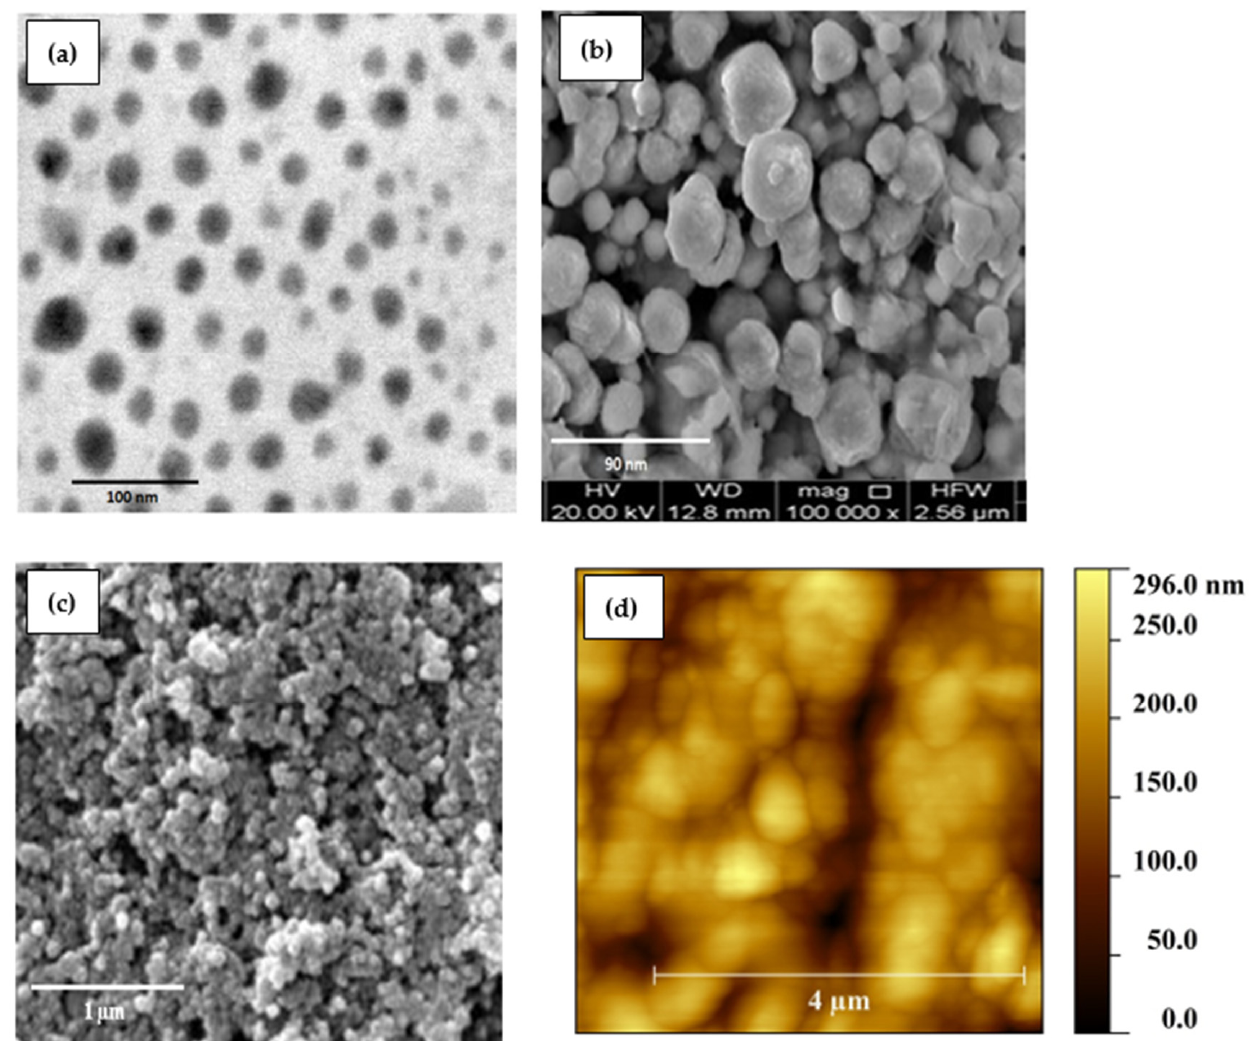
Figure 2. ( a ) TEM and ( b ) SEM images of Cu 2 O nanoparticles; ( c ) SEM and ( d ) AFM images of F8-Cu 2 O nanocomposite thin films.